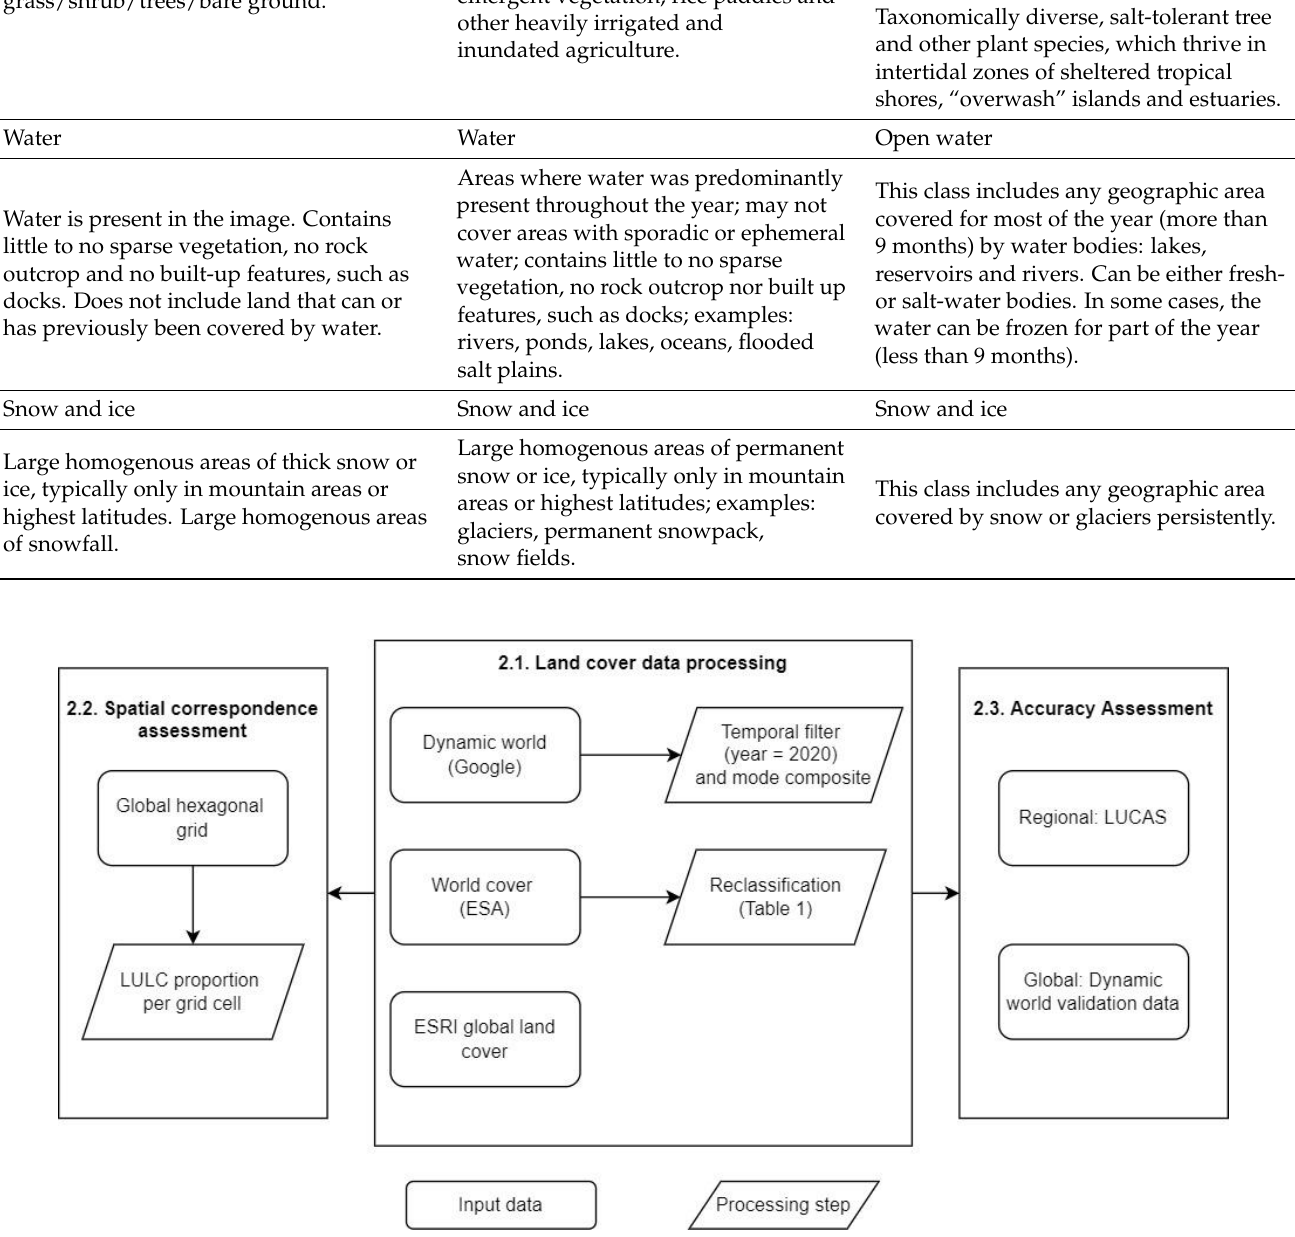
Figure 1. Flowchart of the methods followed in the cross-comparison and accuracy assessment of global 10 m LULC maps.